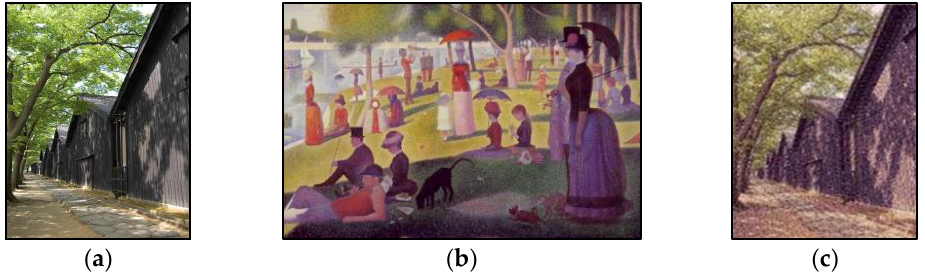
Figure 15. ( a ) Landscape, ( b ) Seurat, “Big Bowl Island Sunday Afternoon”, ( c ) Stylized image.